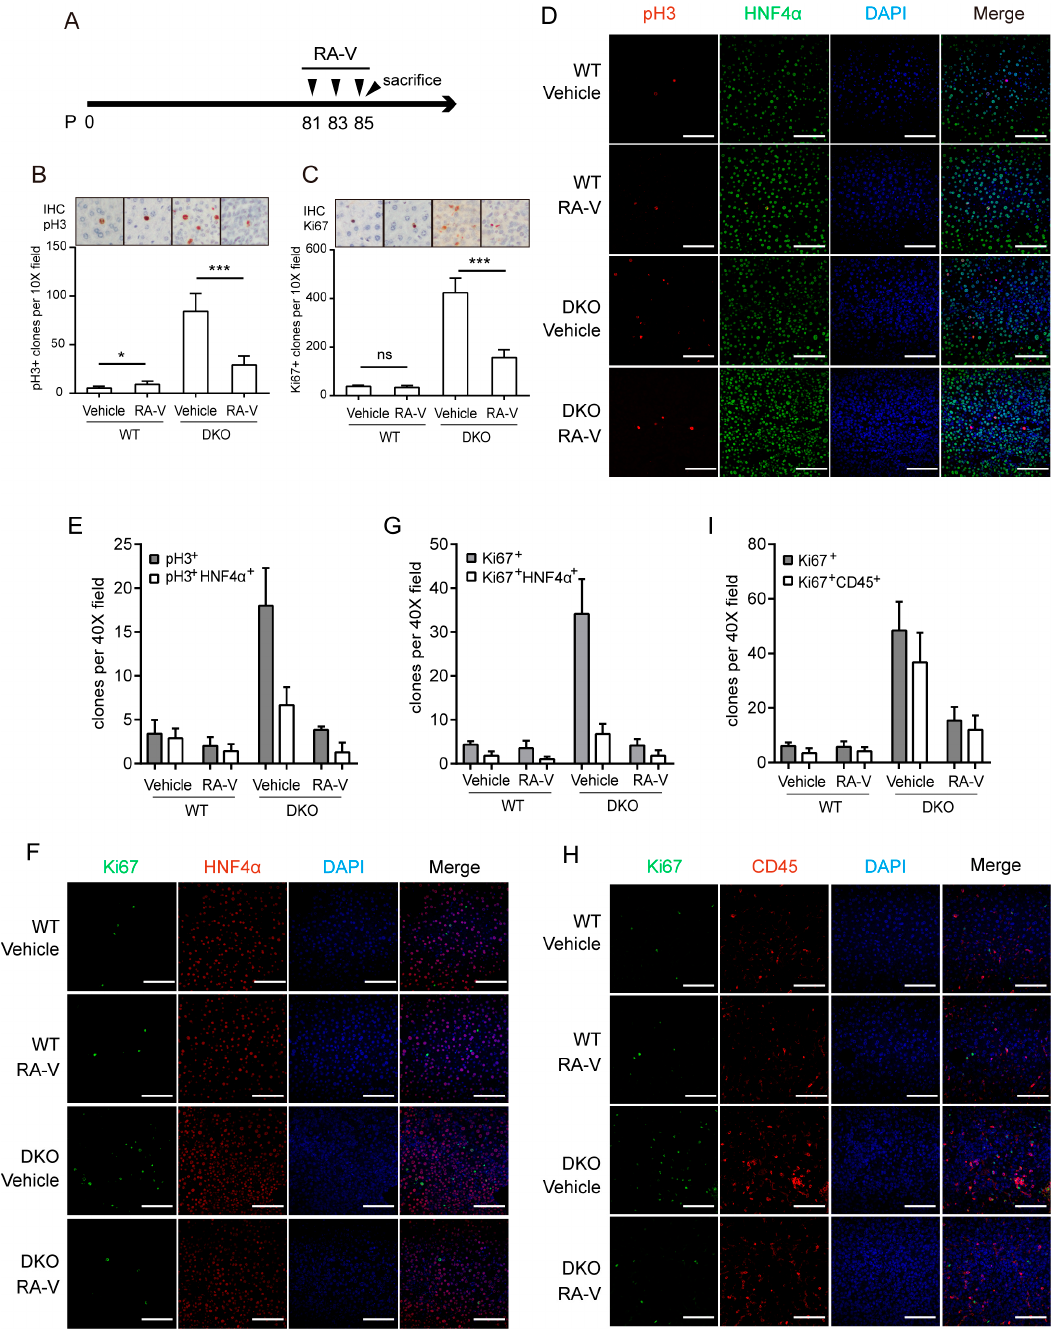
Figure 4. RA-V inhibits proliferation of both hepatocytes and immune cells. ( A ) Schedule of RA-V injection. ( B , C ) IHC staining and quantification of pH3 ( B ) and Ki67 ( C ) positive cells in liver sections from mice treated as ( A ). Images are representative of at least four mice. Six representative views were quantified. Values represent mean ± SD. p values were determined by Student’s t test. ns, not significant; ***, p < 0.001. ( D – I ) Multiplex immunohistochemical staining and quantification of pH3 and HNF4 α ( D and E ), Ki67 and HNF4 α ( F and G ), Ki67 and CD45 ( H and I ). Seven views in liver sections from two or three mice for each group were quantified. Values represent mean ± SD. Scale bars, 100 μ m.